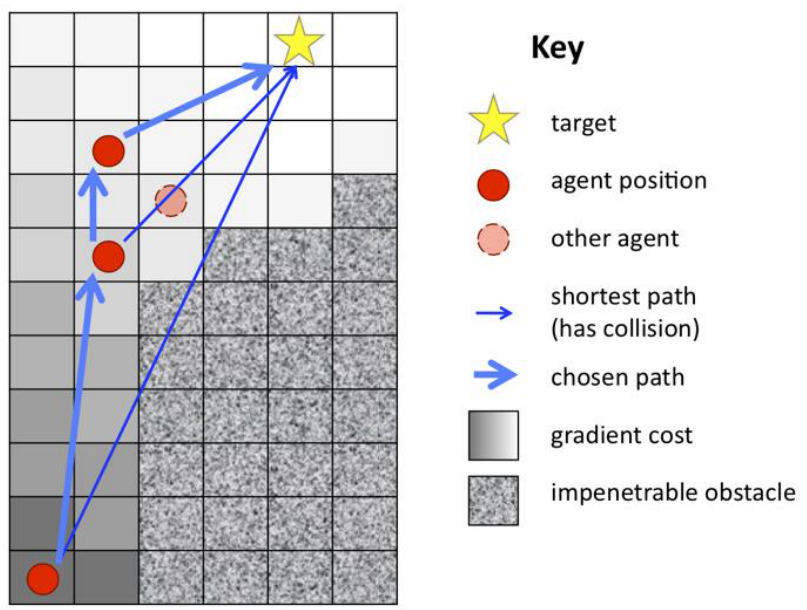
Figure 6. Diagram of the route-planning